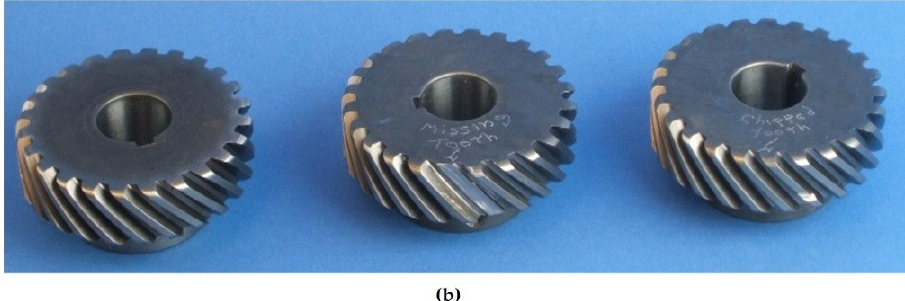
Figure 4. ( a ) Plan view of the experimental setup for the PHM09 dataset. ( b ) Healthy gear, gear with a missing tooth, and gear with a chipped tooth [51].